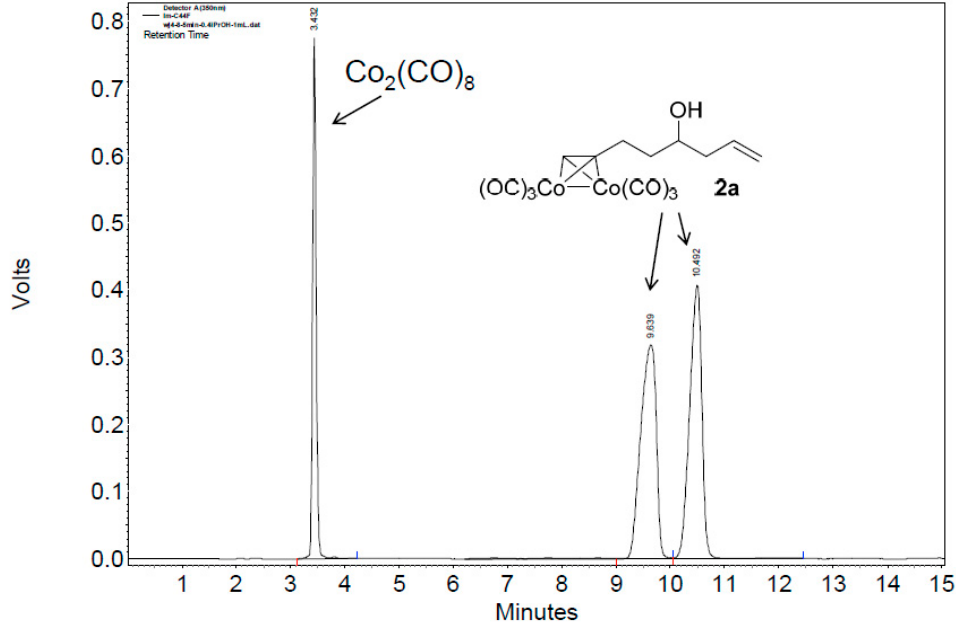
Figure 2. The HPLC chromatogram of the reaction mixture of 1a , Co 2 (CO) 8 , and CH 2 Cl 2 , with CHIRALPAK-IB column, 2-PrOH/ n -hexane 0.4:99.6, 1 mL·min − 1 flow rate, and 350 nm detection wavelength at 25 °C. Sample preparation: 20 µ L of the reaction mixture was taken 5 min after the reaction started, diluted with 0.5 mL n -hexane, and passed through a disposable syringe filter (Nylon 66, 0.22 µm, 13 mm); 5 µL of the filtration was injected.